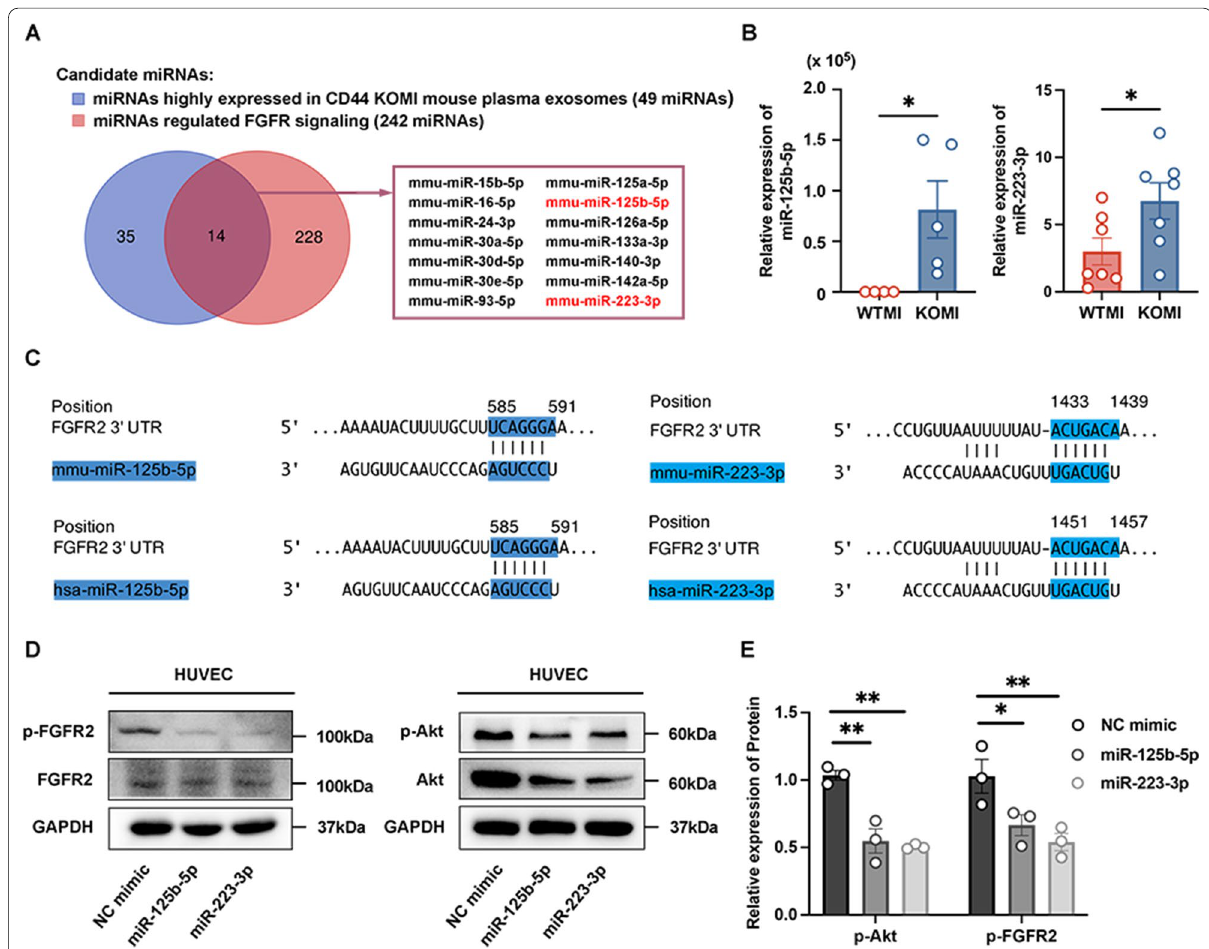
Fig. 6 CD44 removal weakens angiogenic function of plasma exosomes by regulating miRNA-FGFR2 signaling. A Venn diagram of miRNAs regulating FGFR signaling pathway putatively overlapping with highly expressed in KOMI mouse plasma exosomes. B Real-time quantitative polymerase chain reaction (RT-qPCR) analysis of the two candidate miRNAs, miR-125b-5p and miR-223-3p, in border zone of CD44 WT and KO infarcted hearts. Data were normalized to U6 (n 4–7). C TargetScan database predicated interaction between miR-125b-5p, miR-223-3p and FGFR2 = 3’-untranslated region (3’-UTR). D , E Western blot analysis of target genes of miR-125b-5p and miR-223-3p in the FGFR2 pathway (n ** P <